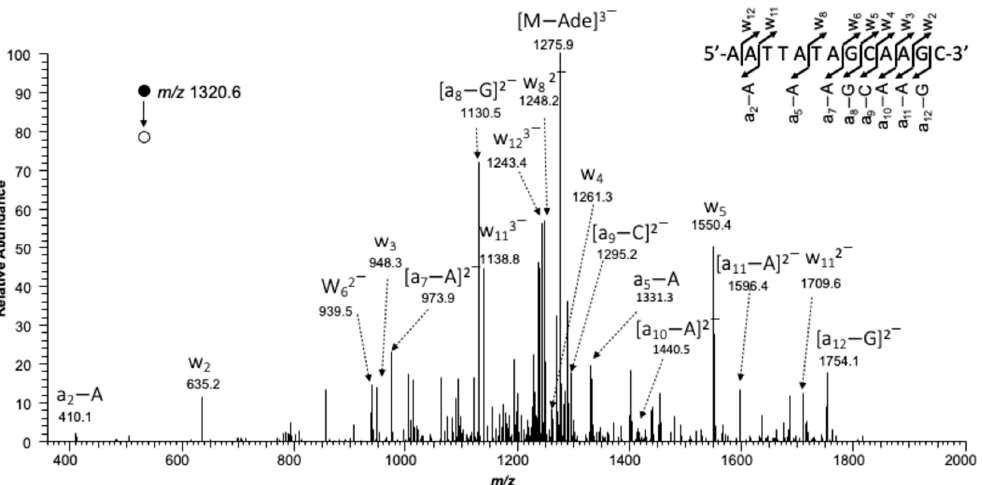
Figure 5. MS/MS for confirming the restriction fragment corresponding to wild-type transcript aris- arising from alkyl-PTE containing ing from alkyl-PTE containing substrates.